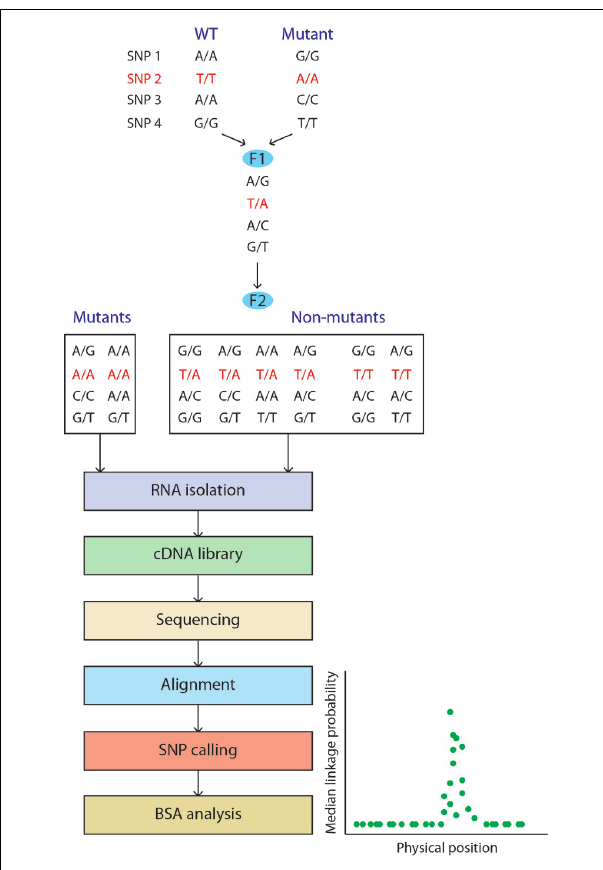
FIGURE 2 | Bulked segregant analysis (BSA) using RNA-seq. Wild-type and mutant plants from different genetic backgrounds are crossed. In this example, four SNPs are listed with SNP 2 being closely related to the mutation to map. A plant from the F1 generation is selfed to generate the F2 segregating population. Mutant and non-mutant plants are processed independently and the BSA analysis allows visualization of the probability of each SNP marker being in complete linkage disequilibrium with the mutated gene.